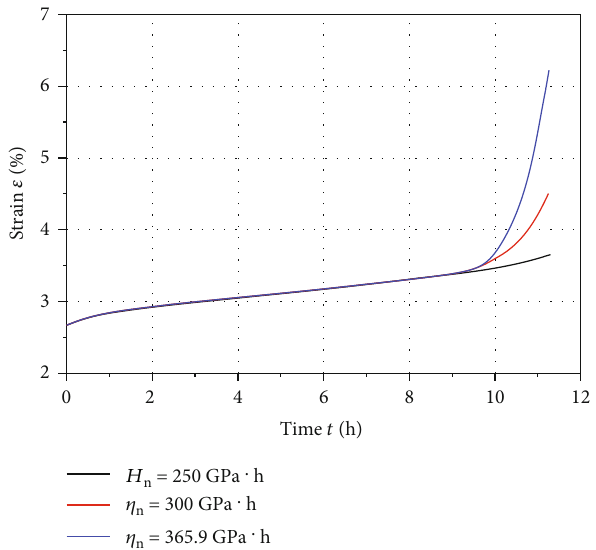
Figure 10: Variation of viscosity coe ffi cient H accelerated creep